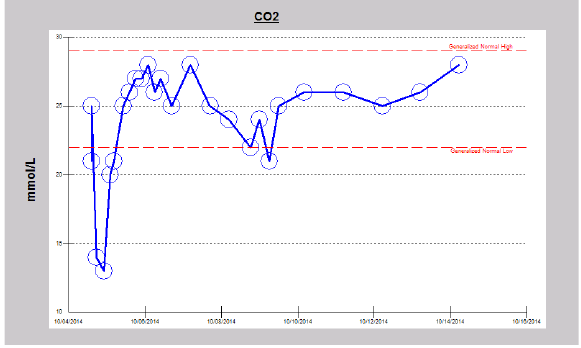
Figure 2. Trajectory of blood ABG CO2 during the first 10 days of the admission with intentional ethylene glycol intoxication.